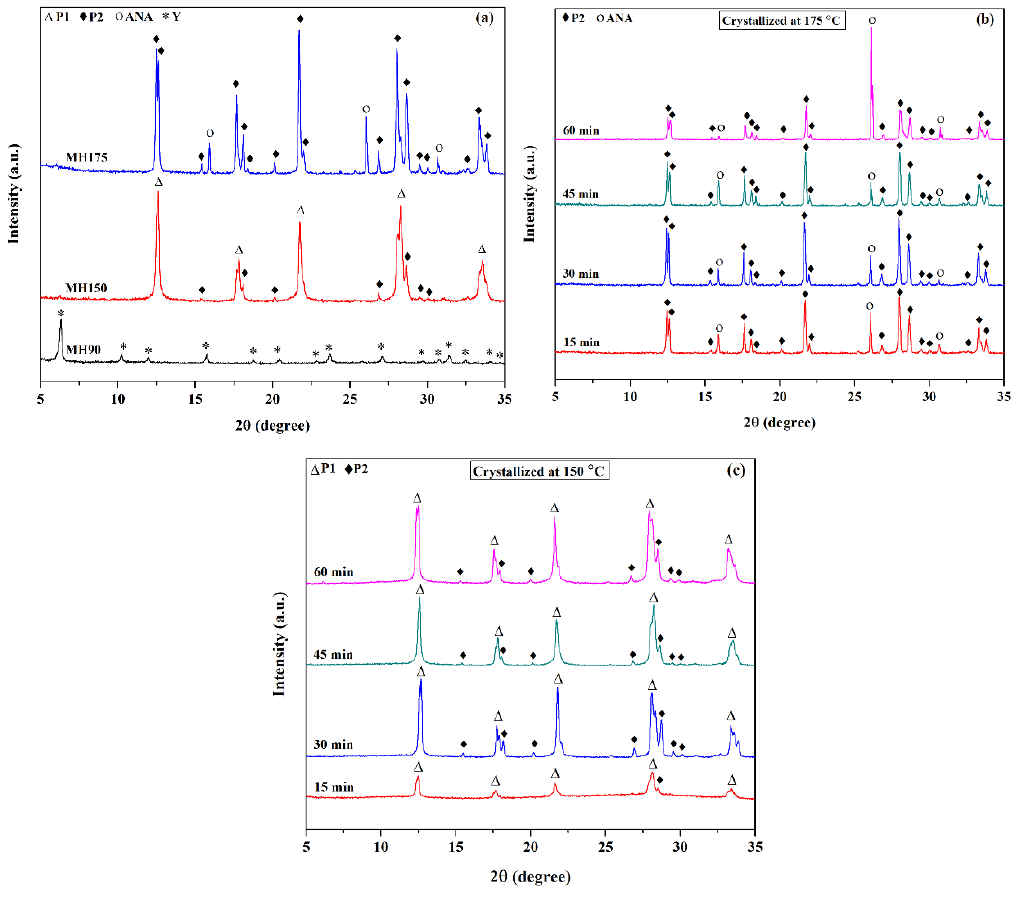
Figure 3. Powder XRD patterns of zeolites from single crystallization via MH ( a ) for 1 h at 90 ◦ C, 150 ◦ C and 175 ◦ C, ( b ) at 175 ◦ C, and ( c ) 150 ◦ C for various times: 15, 30, 45 and 60 min.